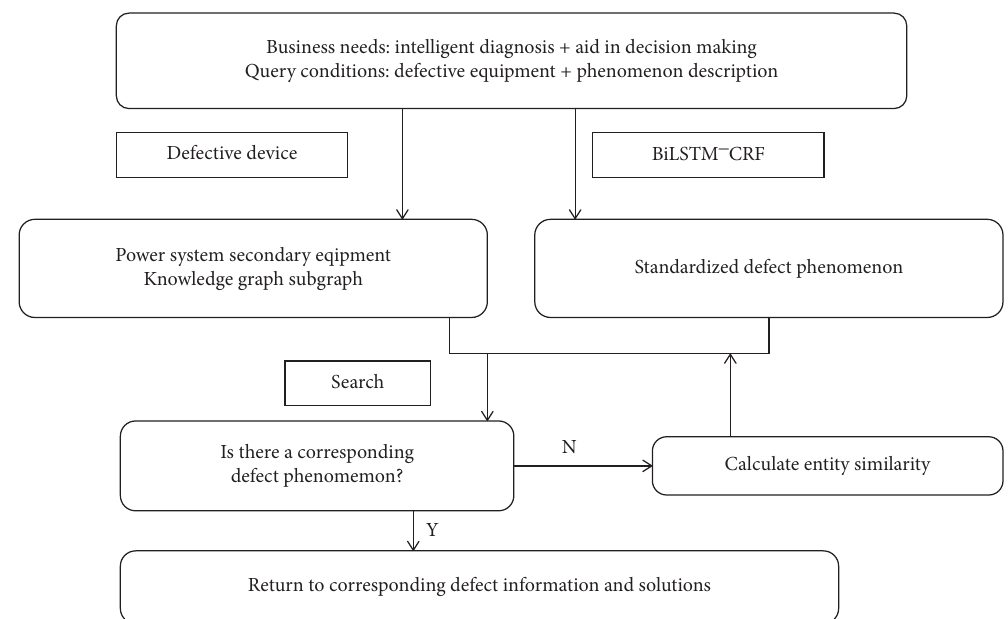
Figure 9: Platform reasoning process.